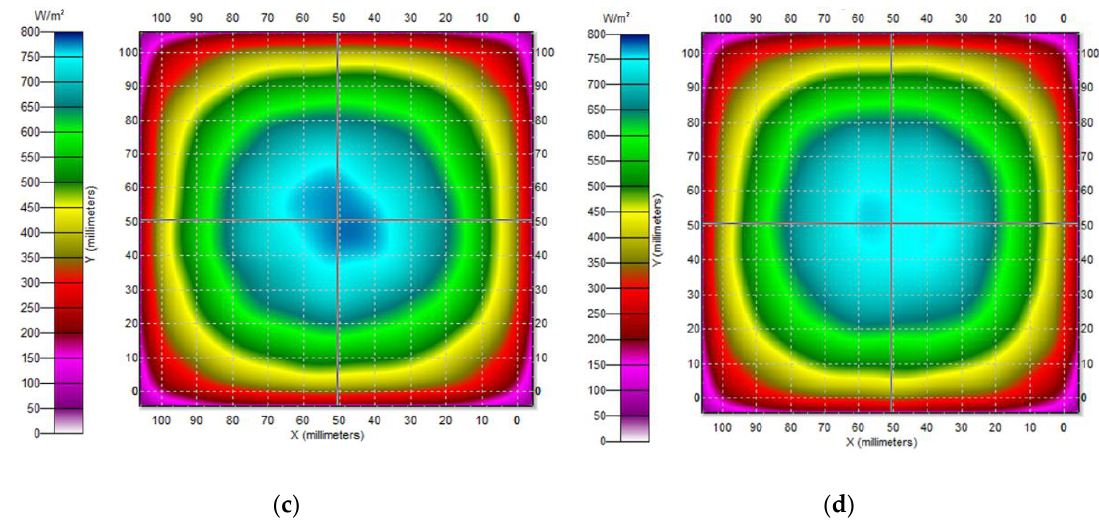
Figure 7. Simulation results of each variable of type B: ( a ) Results of variables (1), ( b ) Results of variables (2), ( c ) Results of variables (3), ( d ) Results of variables (4).